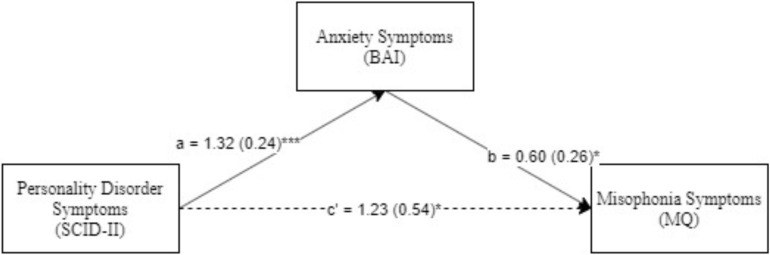
Personality disorder symptoms predicting mosophonia symptoms with anxiety symptoms as mediator. *p < 0.05, ***p< 0.001. Standard errors are in parentheses, solid lines represent significant indirect paths, a = unstandardized regression coefficient for the IV predicting the mediator, b = unstandardized regression coefficient for the mediator predicting the DV with IV and mediator in the model, c = unstandardized coefficient for the IV predicting the DV with the mediator in the model (direct effect). BAI, Beck anxiety inventory total score; MQ, Misphonia Questionaire total score; SCID-II, Structured clinical interview for DSM-IV (Axis II Disorders).